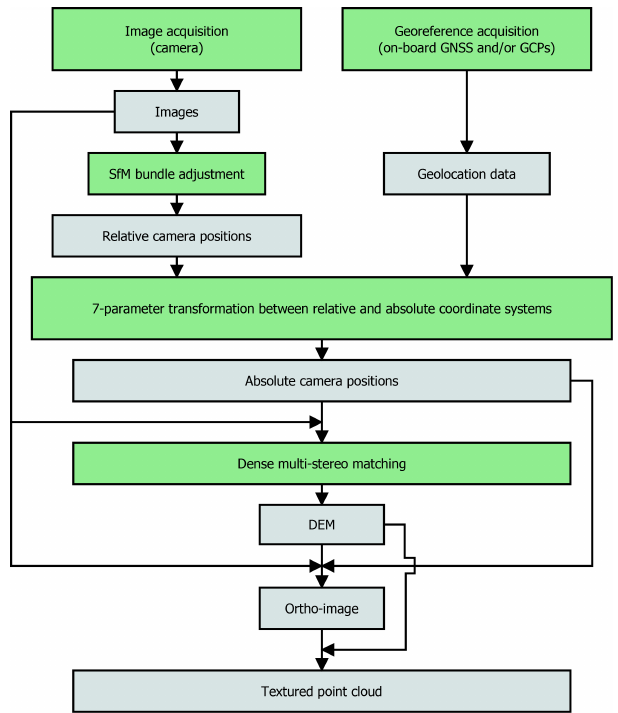
Figure 1. Standard SfM photogrammetry processing workflow. Green boxes are processing steps and grey boxes are